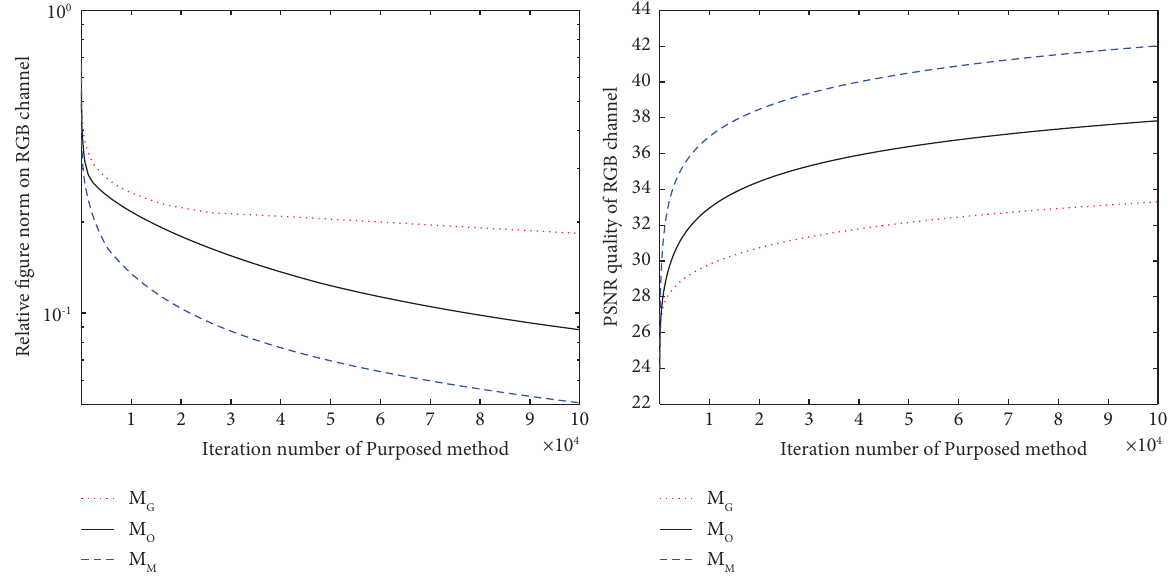
Figure 6: Te relative fgures norm and PSNR plots of the proposed method for all degraded RGB images.